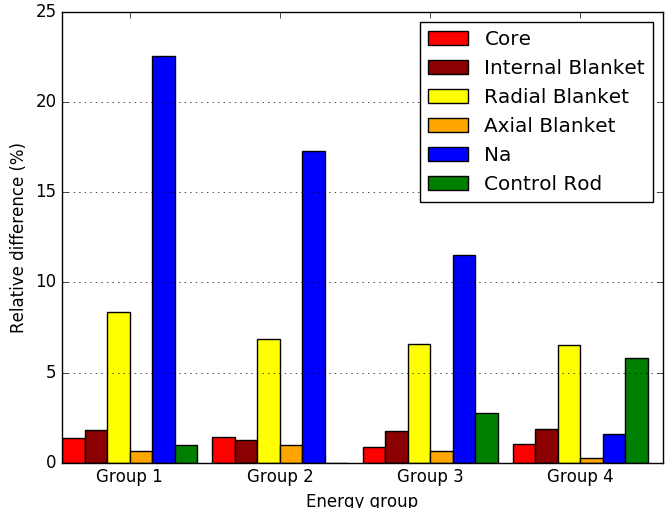
Figure 15. Comparison of region-averaged flux from reference and Parafish Model 3 Case 1.